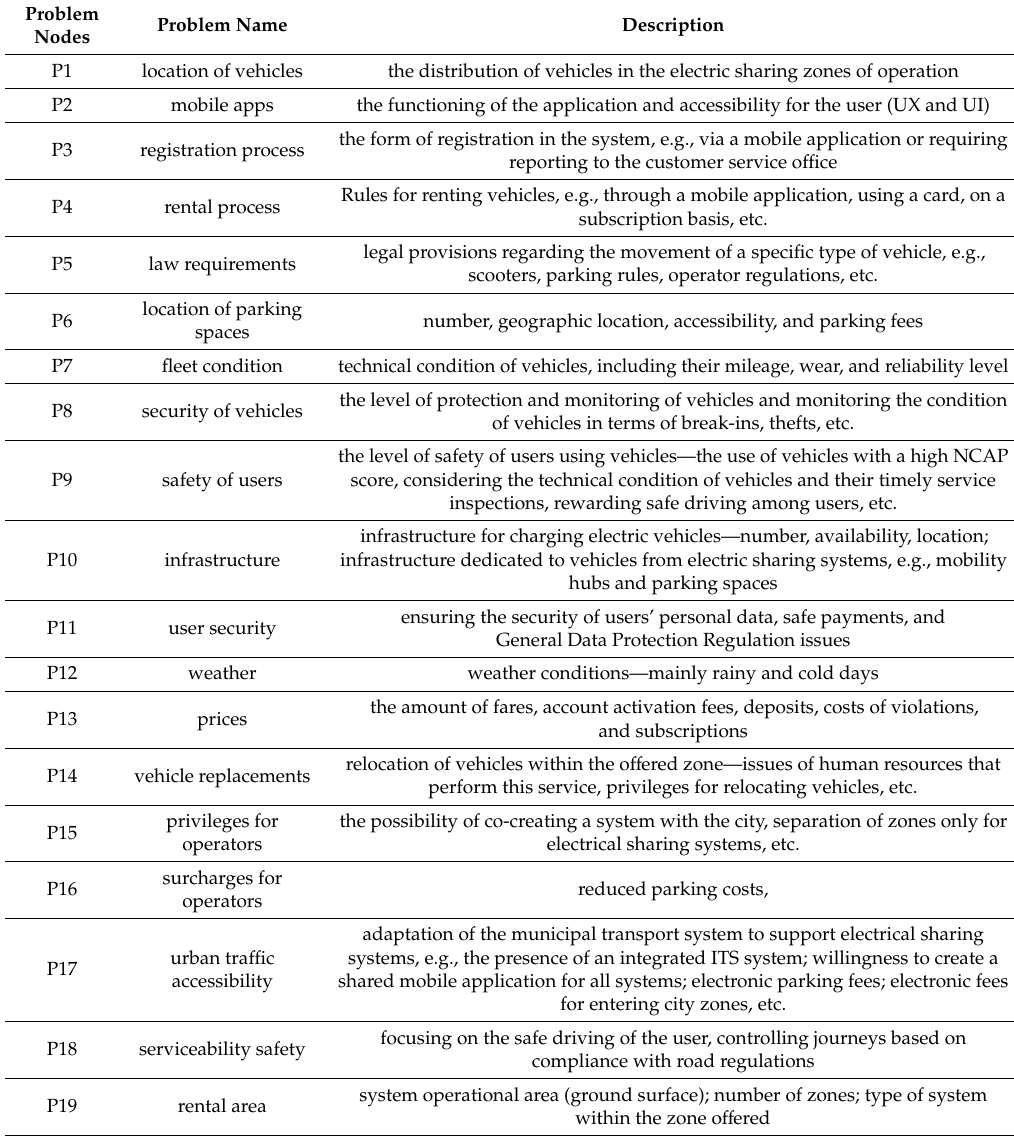
Table 4. Influencing factors (problems) with their corresponding